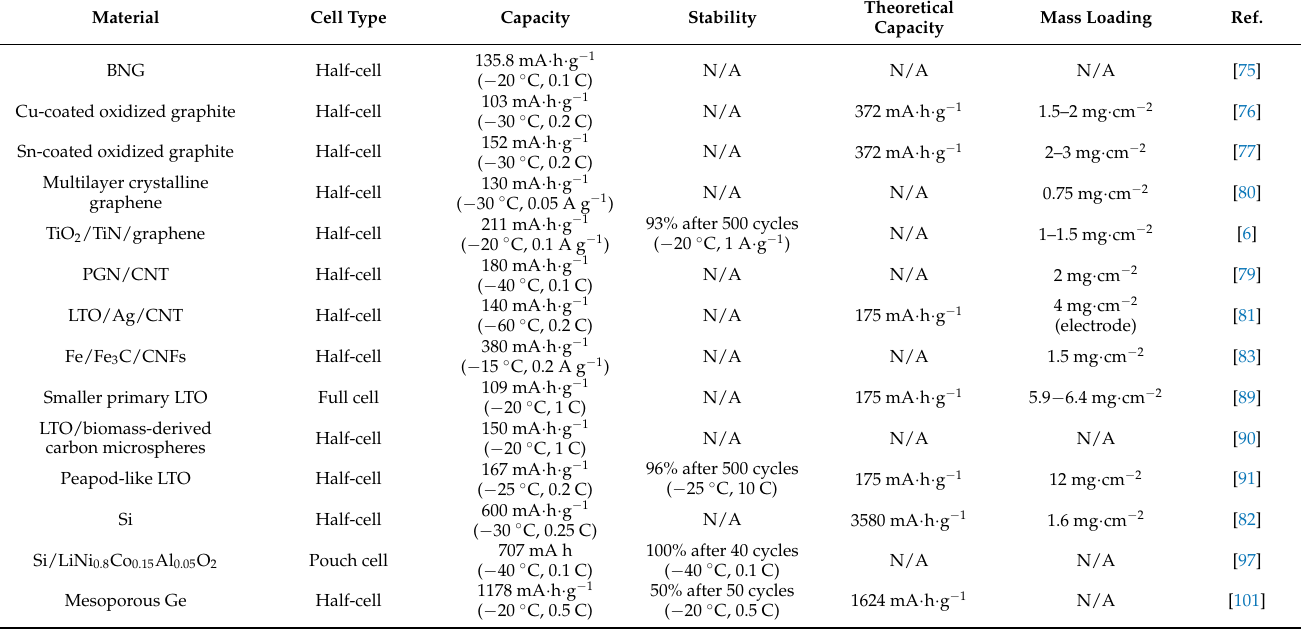
Table 2. Summary of the low-temperature electrochemical properties of different notable